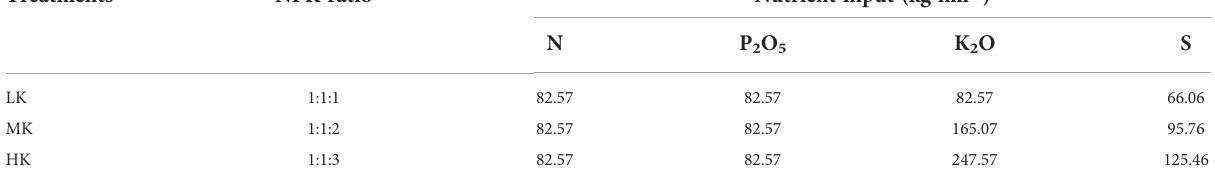
TABLE 1 Nutrient application rate of each treatment.